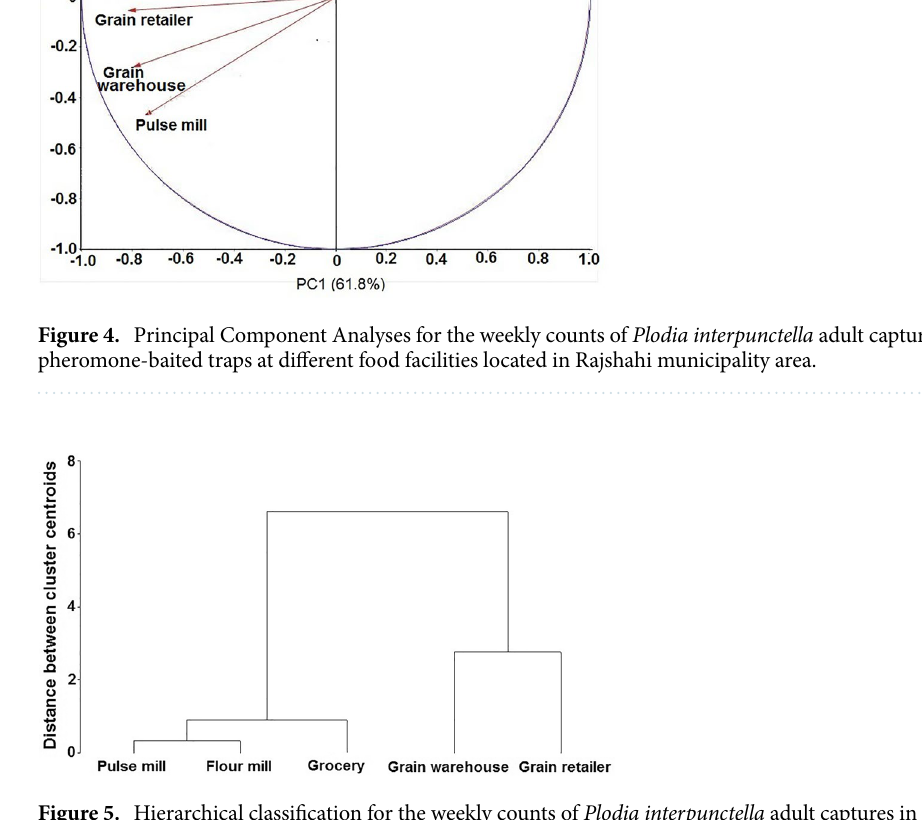
Figure 5. Hierarchical classification for the weekly counts of Plodia interpunctella adult captures in pheromone- baited traps at different food facilities located in Rajshahi municipality